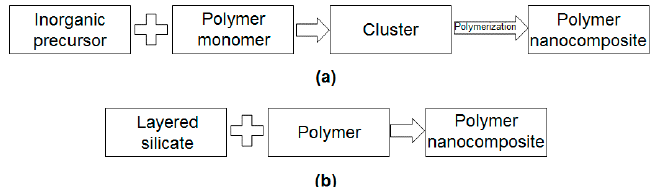
Figure 17. Schematic representation of ( a ) bottom-up and ( b ) top-down methods.